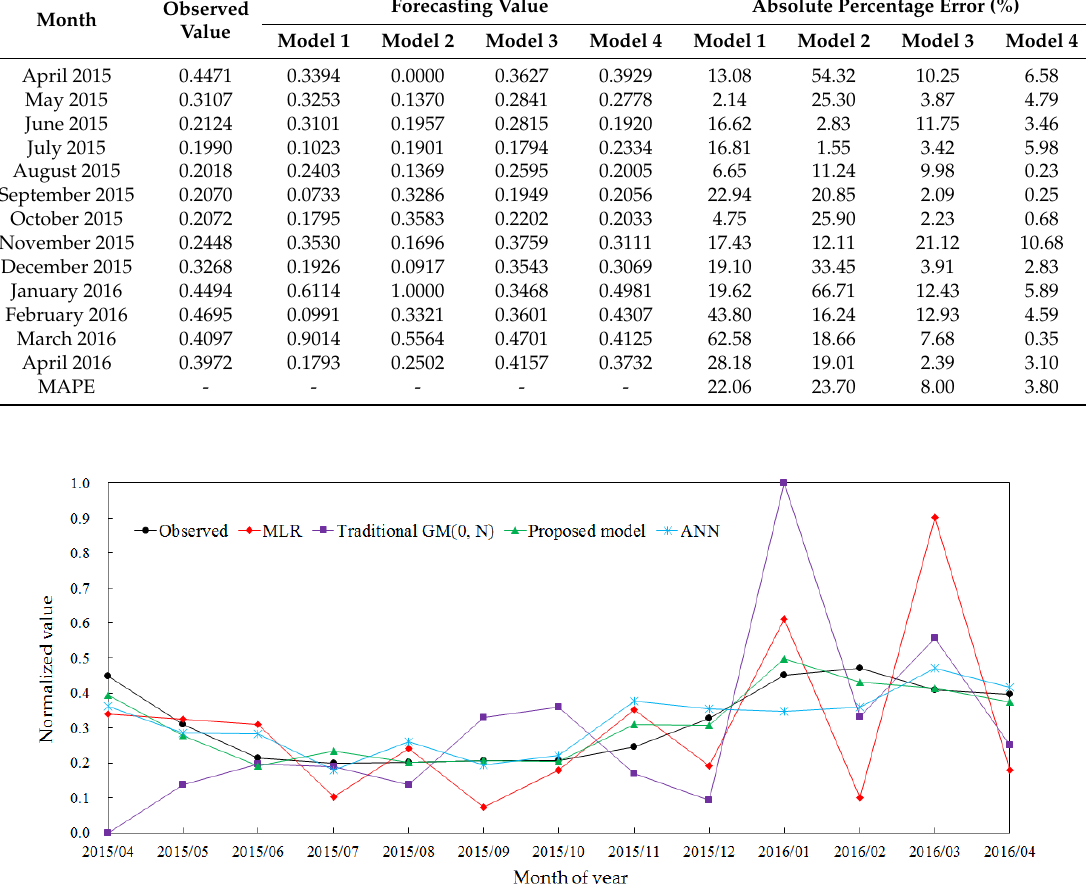
Table 8. Forecasting evaluation results based on the modified Diebold–Mariano (MDM) test.